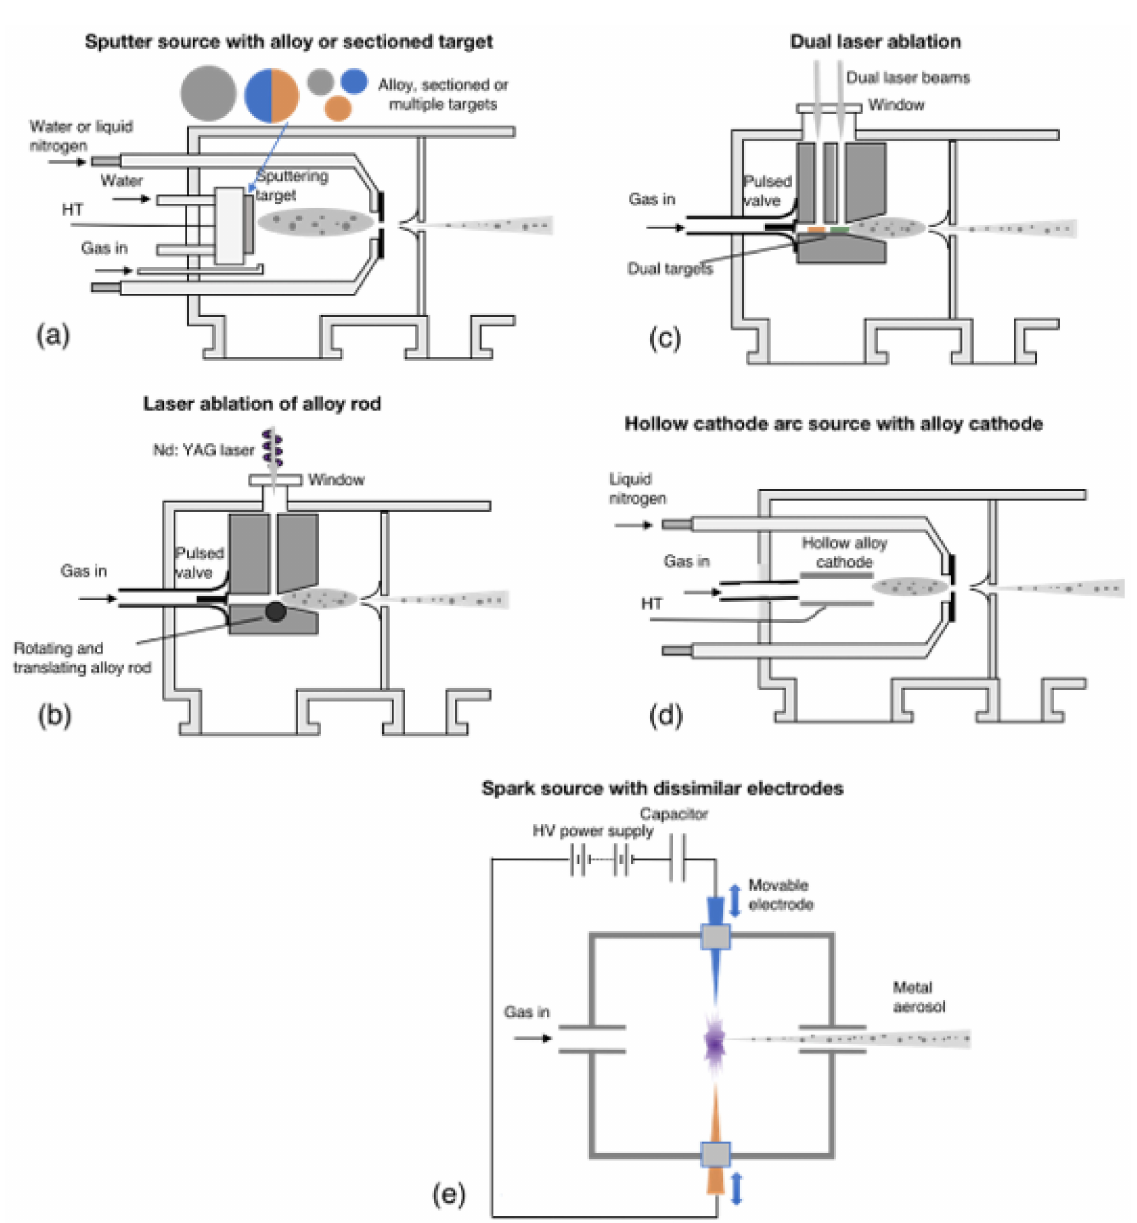
Figure 2. Types of gas-phase source used to produce binary metal nanoparticles using the “simultaneous” method. ( a ) A sputter source; ( b ) a dual laser ablation source; ( c ) a laser ablation source; ( d ) a hollow cathode arc source; ( e ) a spark ablation